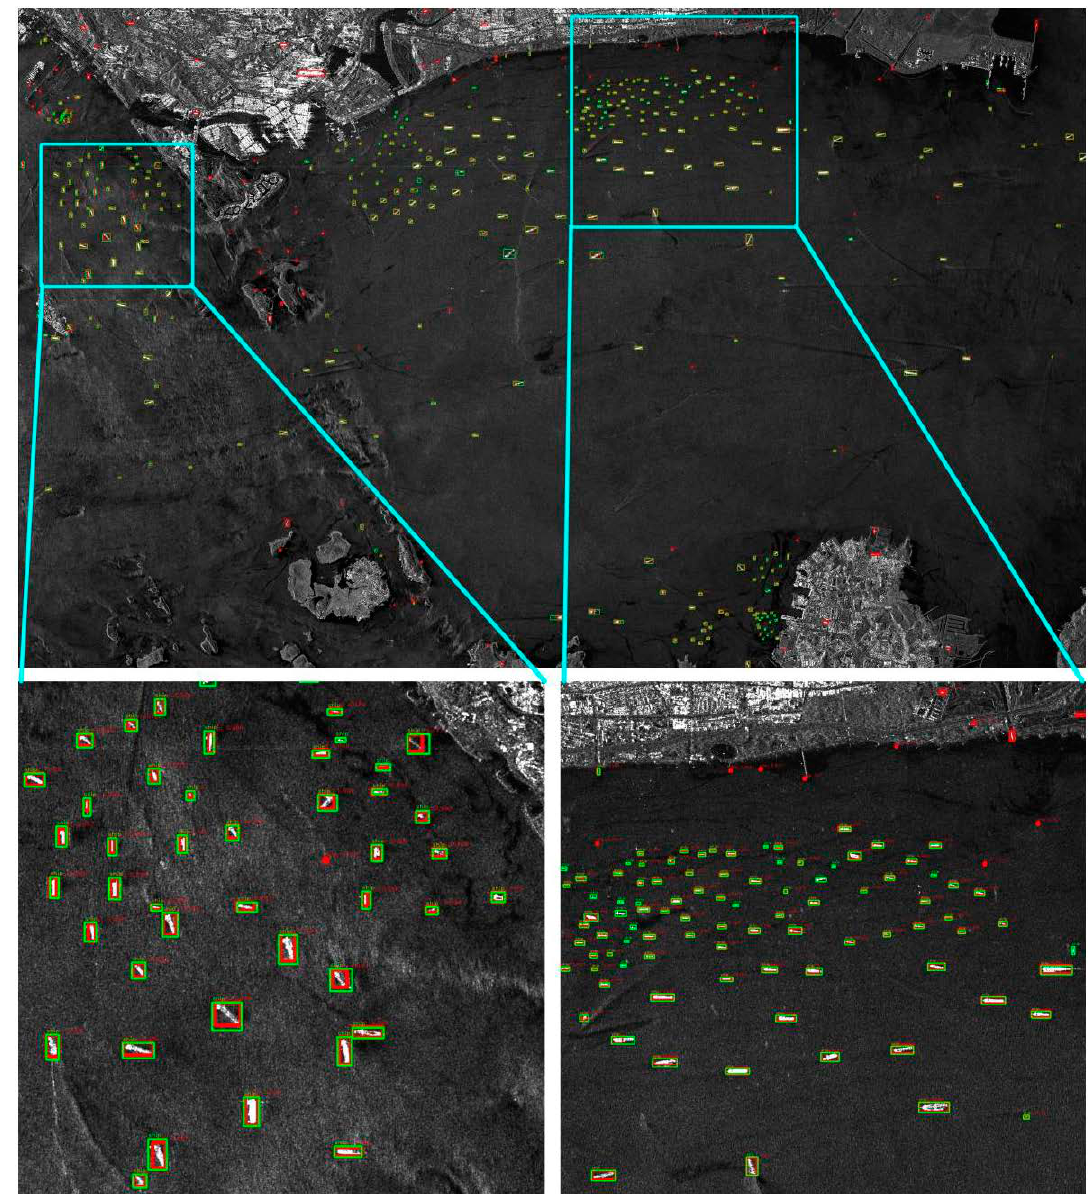
Figure 16. Ship detection results with the HR-SDNet on the real SAR image from the Strait of Singapore. (Red boxes denote predicted results; green boxes denote ground-truth).